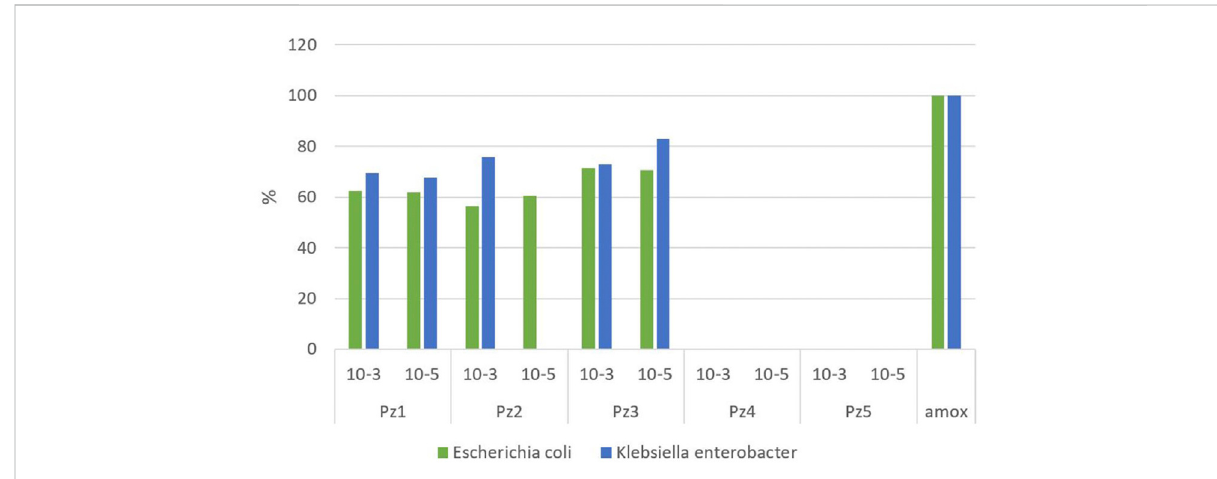
Percentage of inhibition achieved by the pyrazole derivatives in the experiment compared to